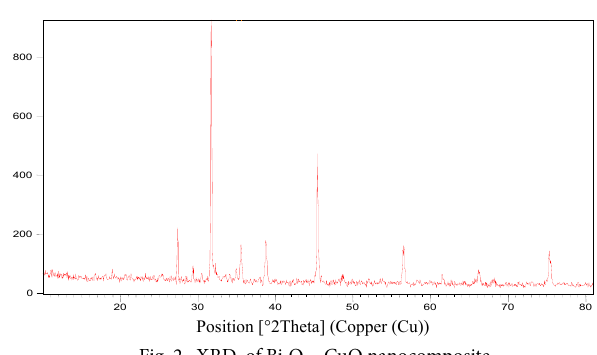
O – CuO nanocomposite 2 3